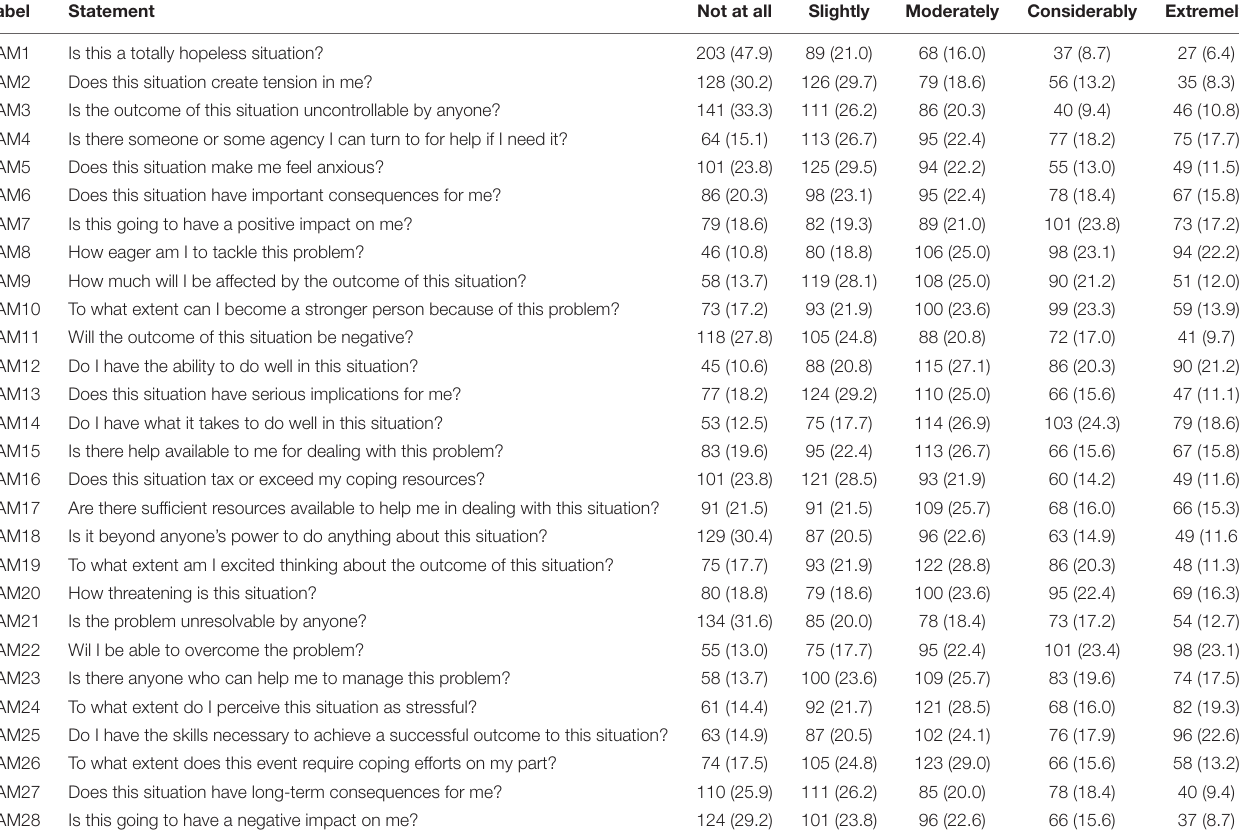
TABLE 1 | Frequency and percentage for category response per